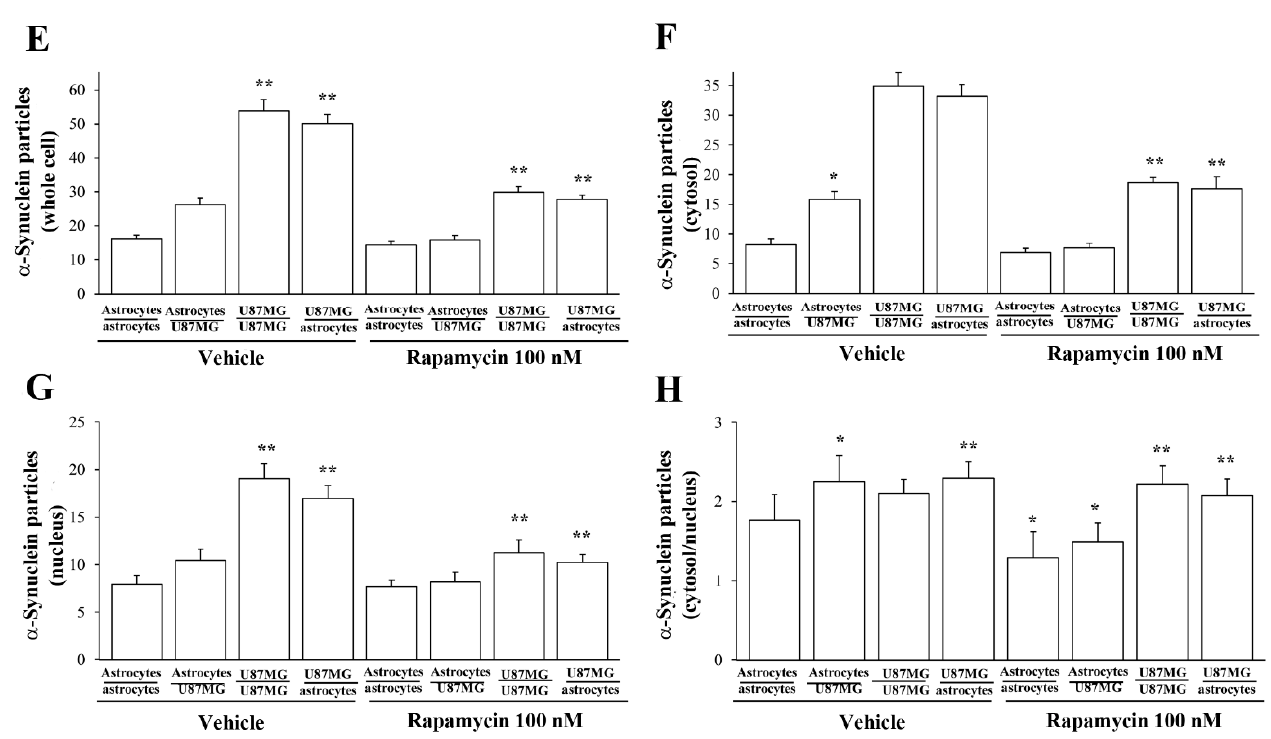
Figure 15. Rapamycin reduces the amount of α -syn in astrocytes co-cultured with GBM cells. Repre- sentative micrographs show α -syn immuno-gold particles within both cytosol and nucleus (black arrows) of astrocytes co-cultured with astrocytes treated with rapamycin ( A ), astrocytes co-cultured with GBM cells treated with rapamycin ( B ), GBM cells co-cultured with GBM cells treated with rapamycin ( C ), and GBM cells co-cultured with astrocytes treated with rapamycin ( D ). N = nucleus; V = vacuoles. Ultrastructural stoichiometry of α -syn immuno-gold in co-cultures of astrocytes and GBM cells, both in baseline conditions and following rapamycin administration are reported in the graphs. In detail, graphs report the number of α -syn immuno-gold-particles within whole cell ( E ), cytosol ( F ), and nucleus ( G ). The ratio of α -syn immuno-gold particles within cytosol vs. nucleus is reported in ( H ). These data are obtained from astrocytes co-cultured with astrocytes, astrocytes co-cultured with GBM cells, GBM cells co-cultured with GBM, and GBM cells co-cultured with astrocytes, both in baseline conditions and following rapamycin. Data are given as the mean ± S.E.M. from N = 30 cells per each experimental group. * p < 0.05 compared with astrocytes co-cultured with astrocytes; ** p < 0.05 compared with astrocytes co-cultured with GBM cells. Scale bar = 0.12 µ